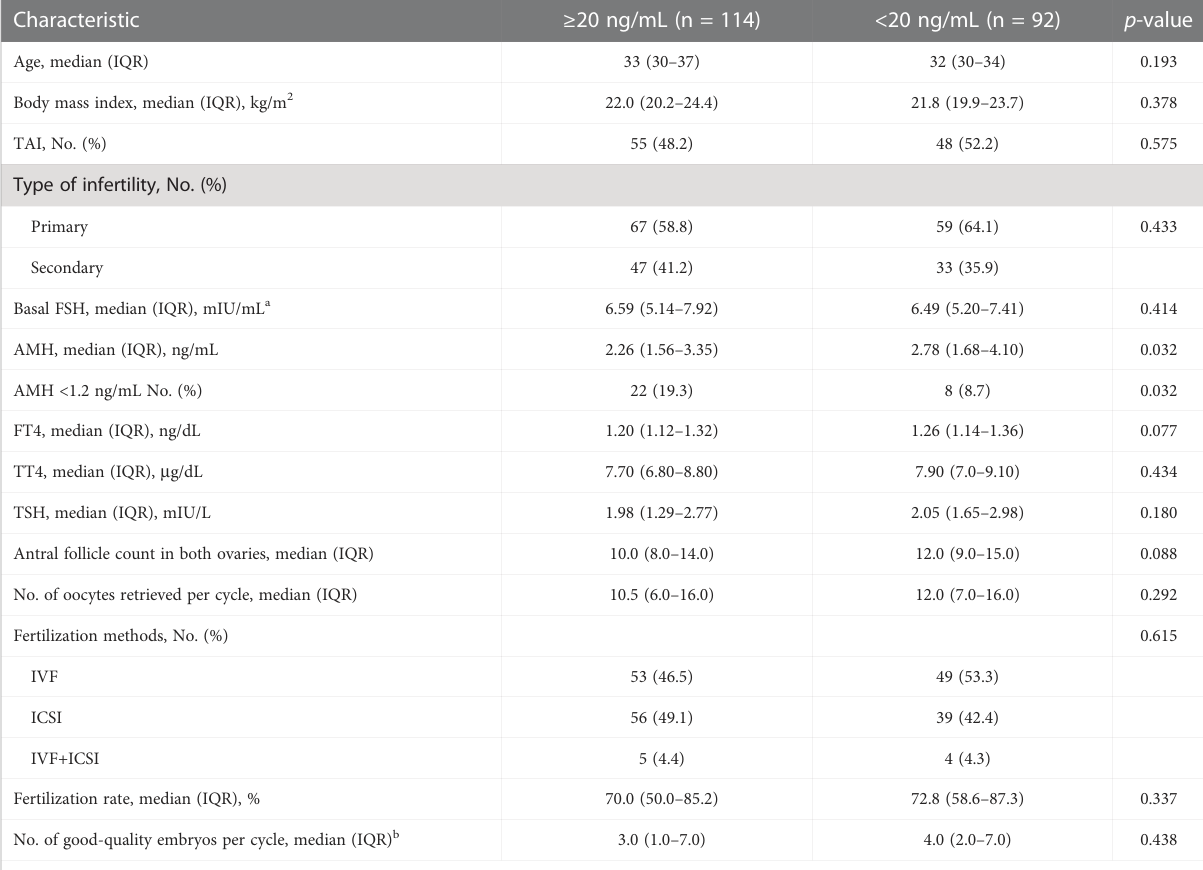
TABLE 3 Baseline characteristics and in vitro fertilization data of patients based on follicular fl uid vitamin D status. Characteristic